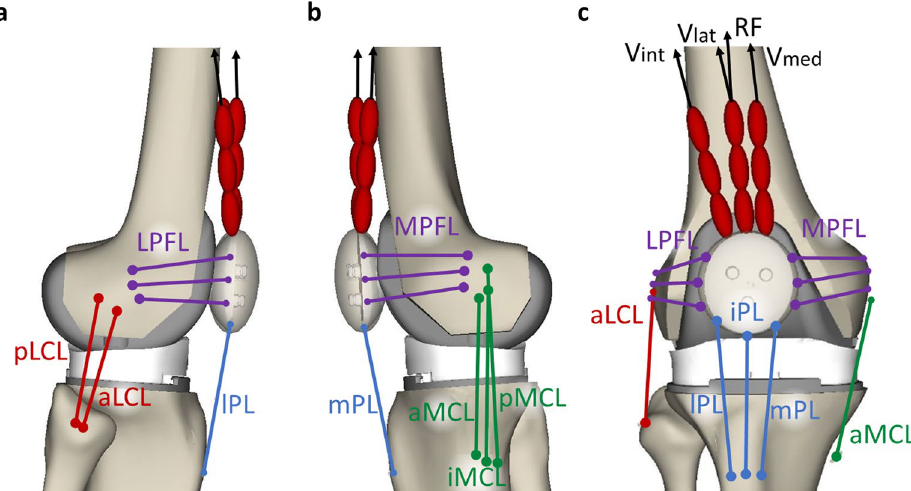
Figure 1. Ligament bundles and muscles included into the multibody model. ( a ) Lateral view; ( b ) medial view; ( c ) frontal view. Red ellipsoids represent tendons of the M. quadriceps femoris and black upward arrows